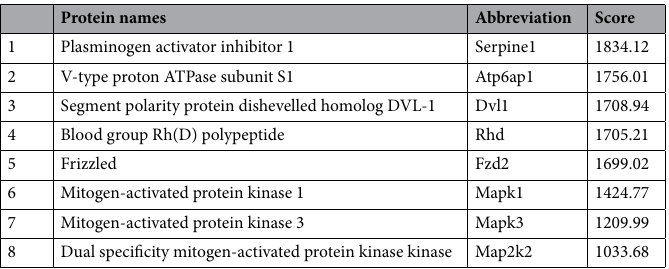
Table 1. The scores of the part of the target proteins of LrB acting on BMMs.